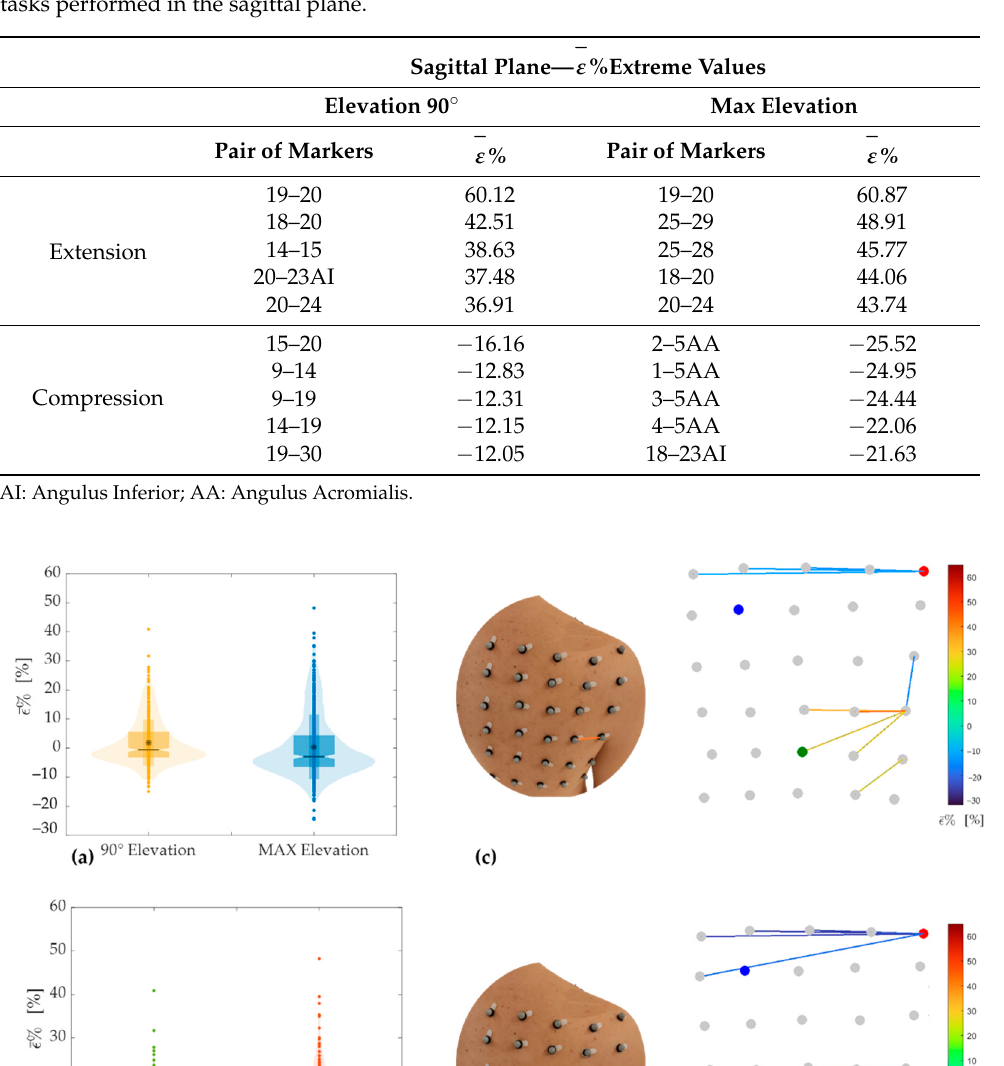
Table 4. Extreme percentage values of the mean strain 𝜀̅% in both extension and compression dur- ing tasks performed in the sagittal plane.